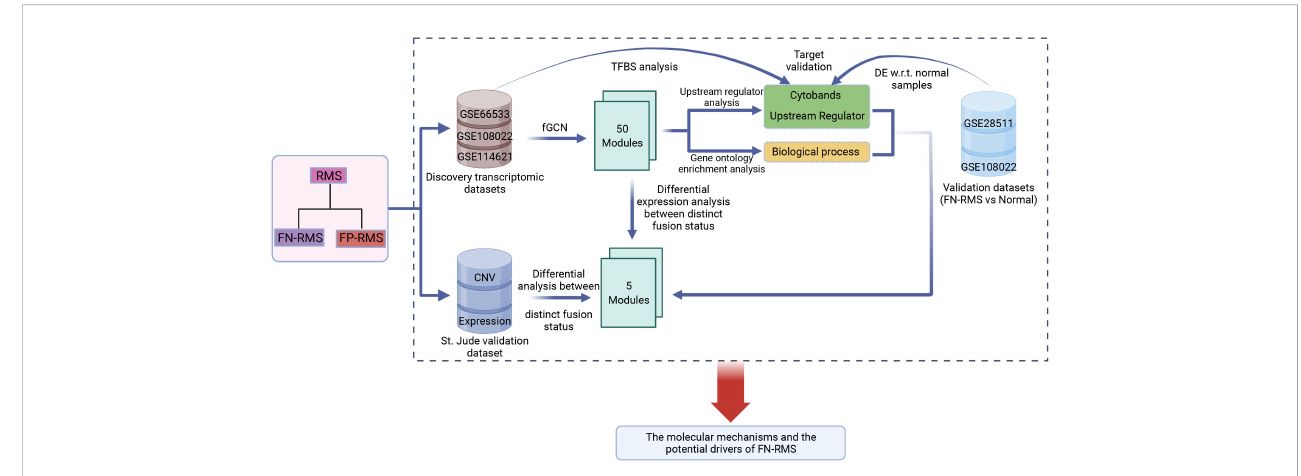
FIGURE 1 Study work fl ow: fGCN, frequent co-expression network minging; DE w.r.t. normal samples, Differential expression analysis with respect to normal